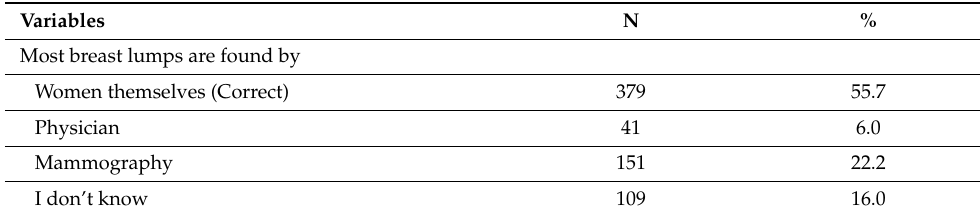
Table 2. Breast self-examination items of the